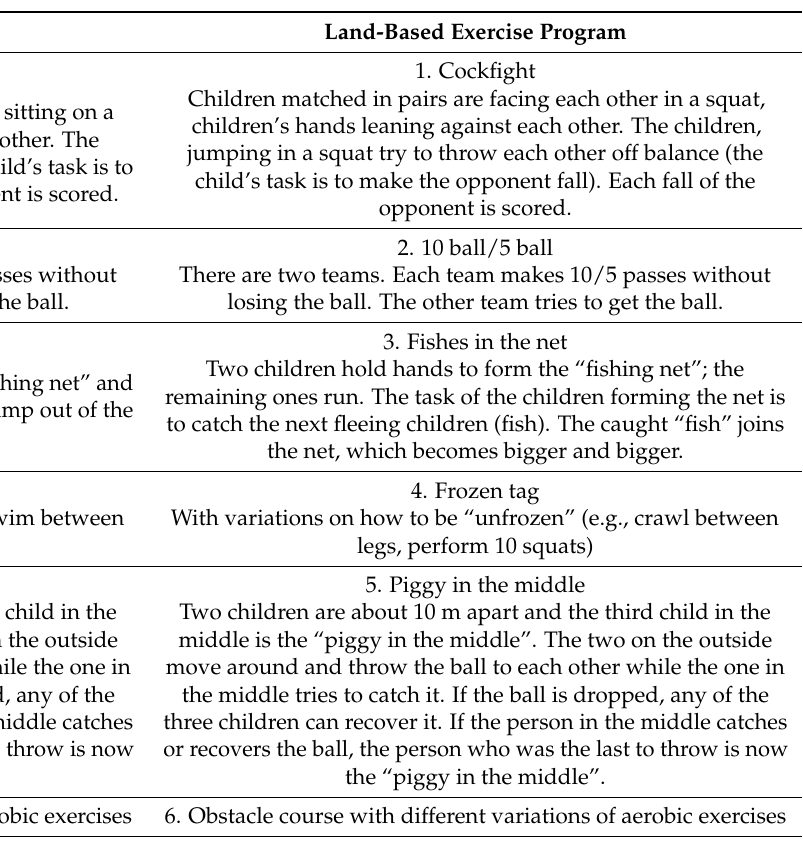
Table 3. Games and plays used in the water-based and land-based exercise